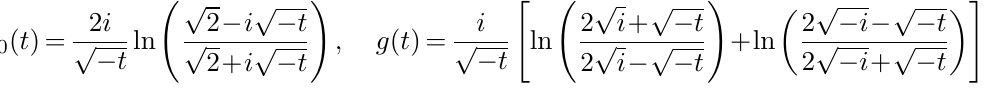
p = 1 ; 2 ; 3, M = 1 = 20 j j